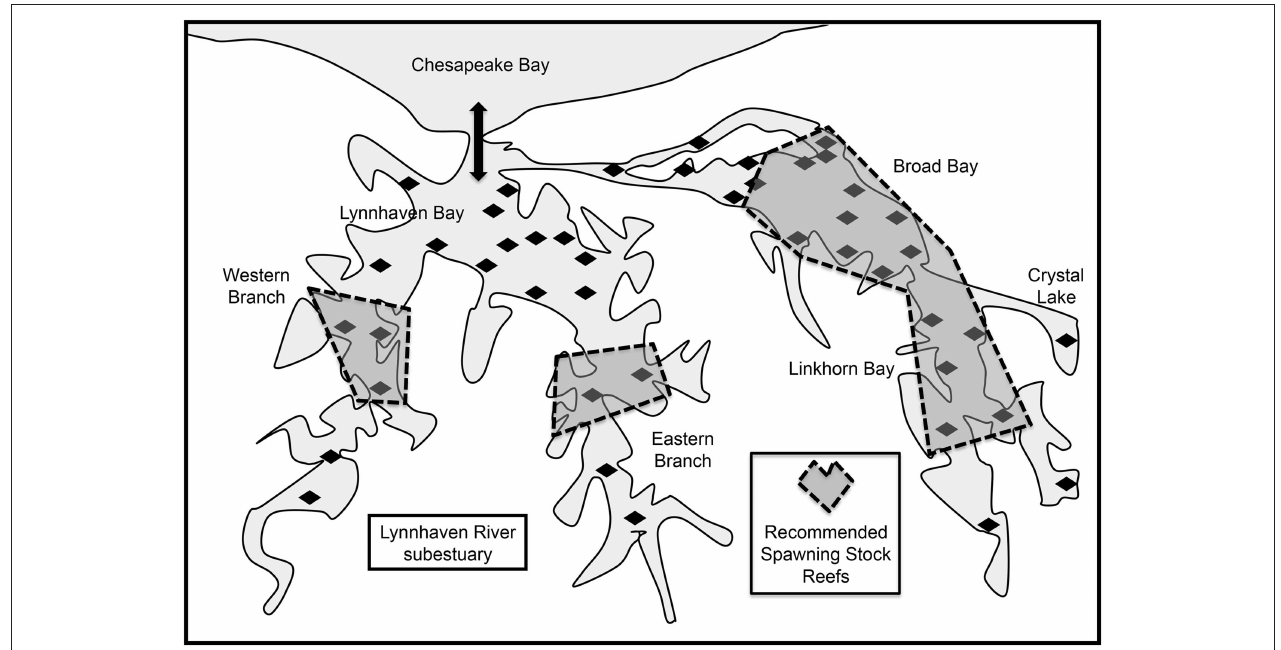
FIGURE 1 | Location of the Lynnhaven River subestuary, potential oyster reef restoration sites (diamonds) determined from historical information (Baylor, 1893, 1894, 1895; Chipman, 1948), and sites in the subestuary for restoration of spawning stock (dashed polygons) recommended by Lipcius et al. (2008) as putative sources. Thick arrow indicates tidal exchange through Lynnhaven Inlet between Lynnhaven Bay and Chesapeake Bay. Coordinates of Lynnhaven Inlet: 36 ◦ 54 ′ 27.02 ′′ N, 76 ◦ 05 ′ 31.07 ′′ W.